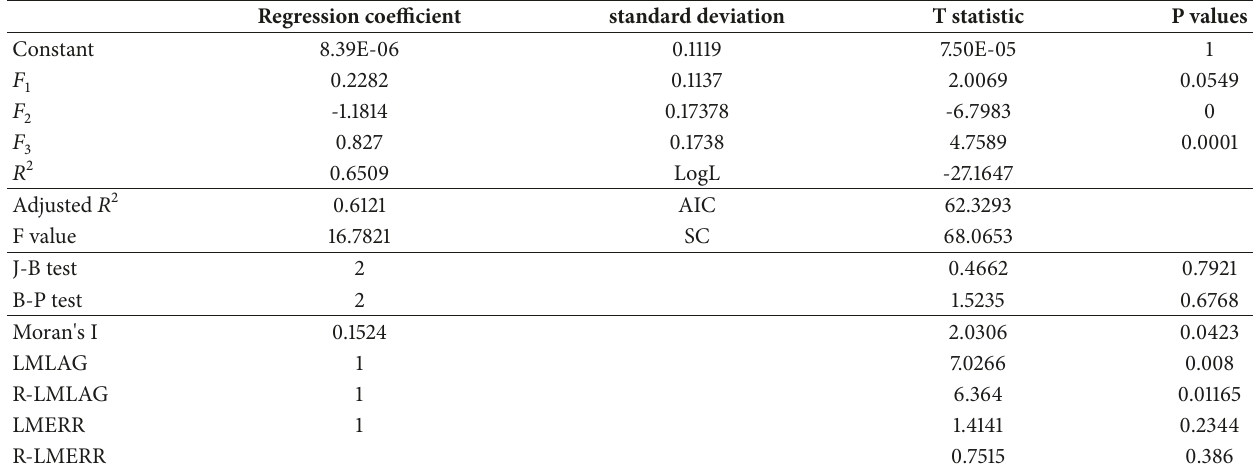
Table 6: OLS estimation results.